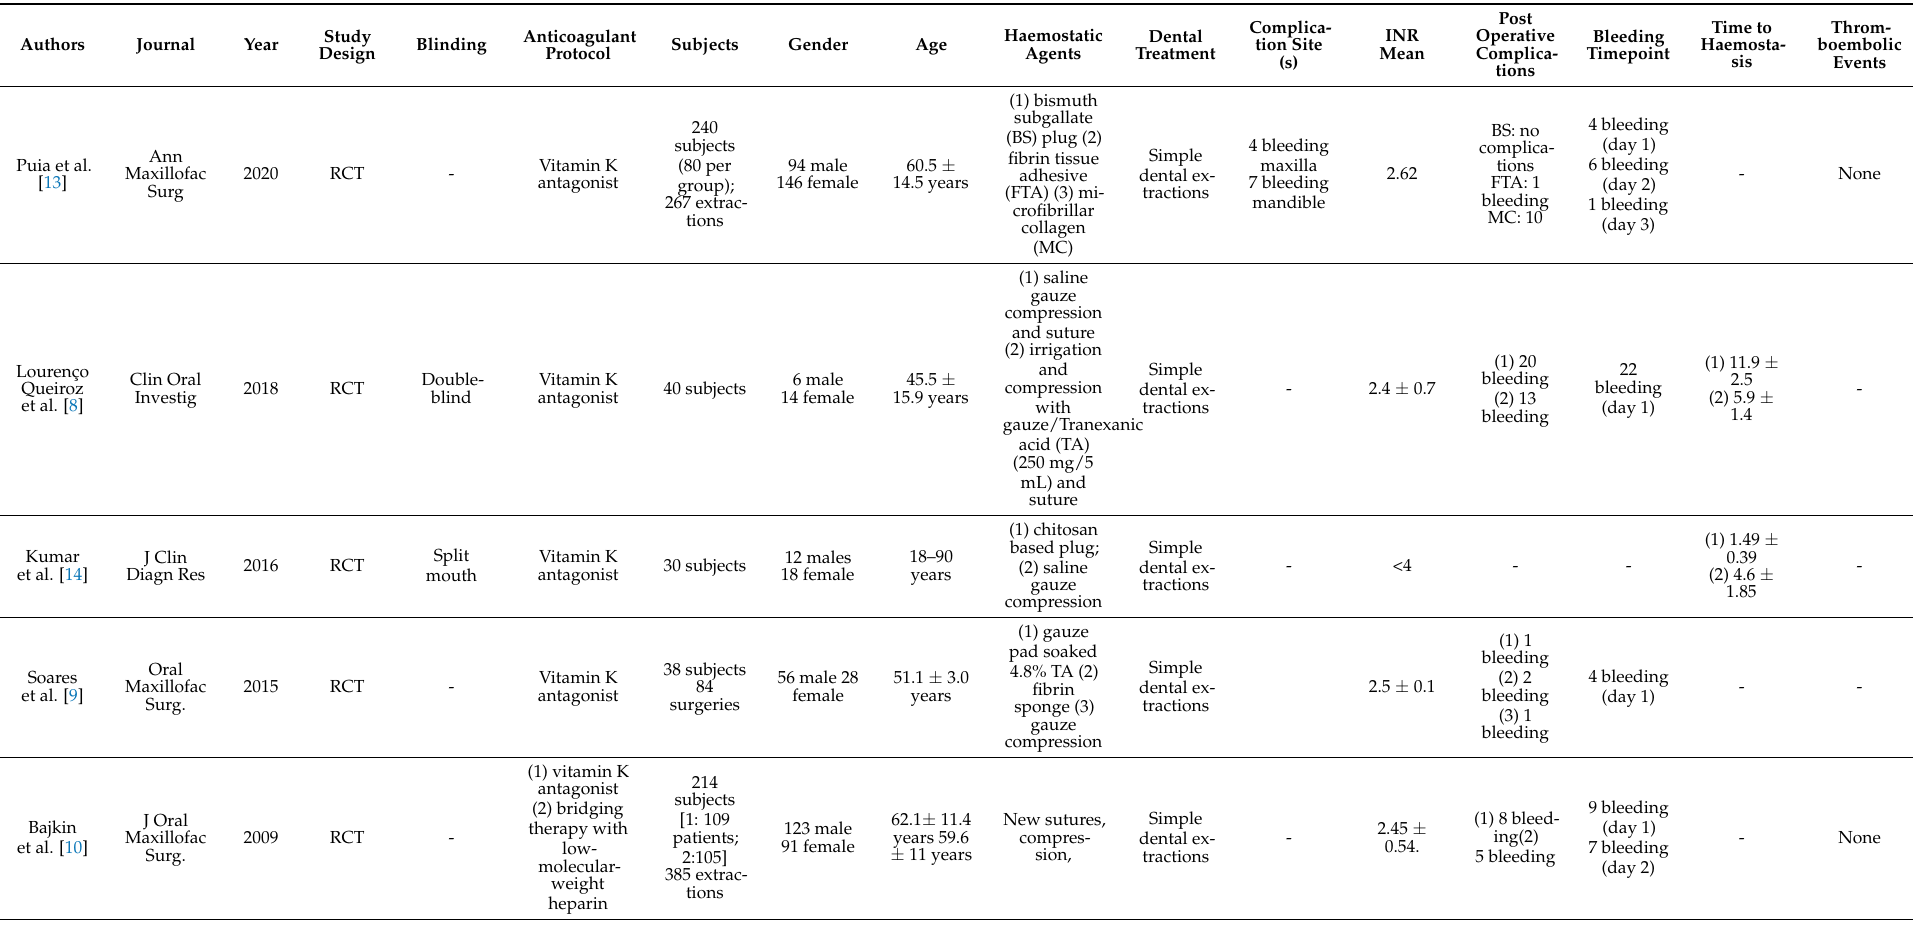
Table 2. Summary of the studies included for the qualitative synthesis [RCT: randomized clinical